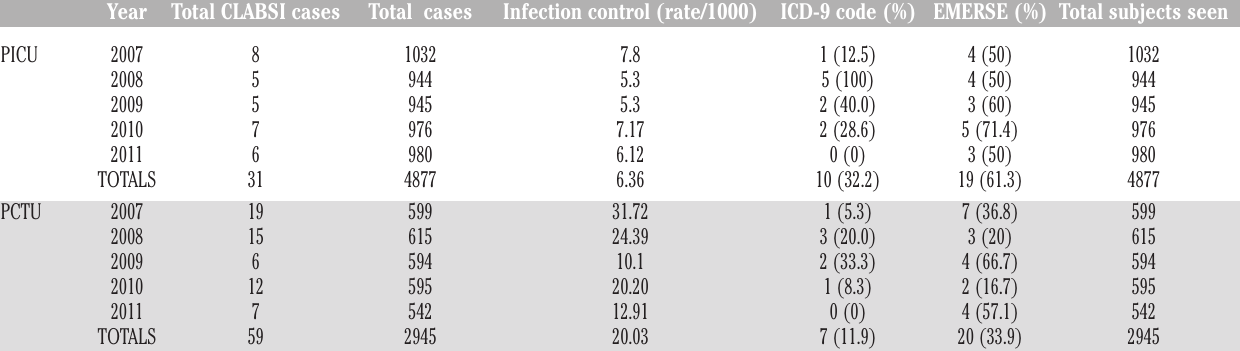
Table 1. The table displays the total number of subjects seen in the Pediatric Intensive Care Unit and Pediatric Cardiothoracic Intensive Care Unit by year from 2007 to 2011, the number of subjects identified by infection control, the number of subjects with the proper ICD-9CM code at discharge, as well as the number of cases with EMERSE searchable